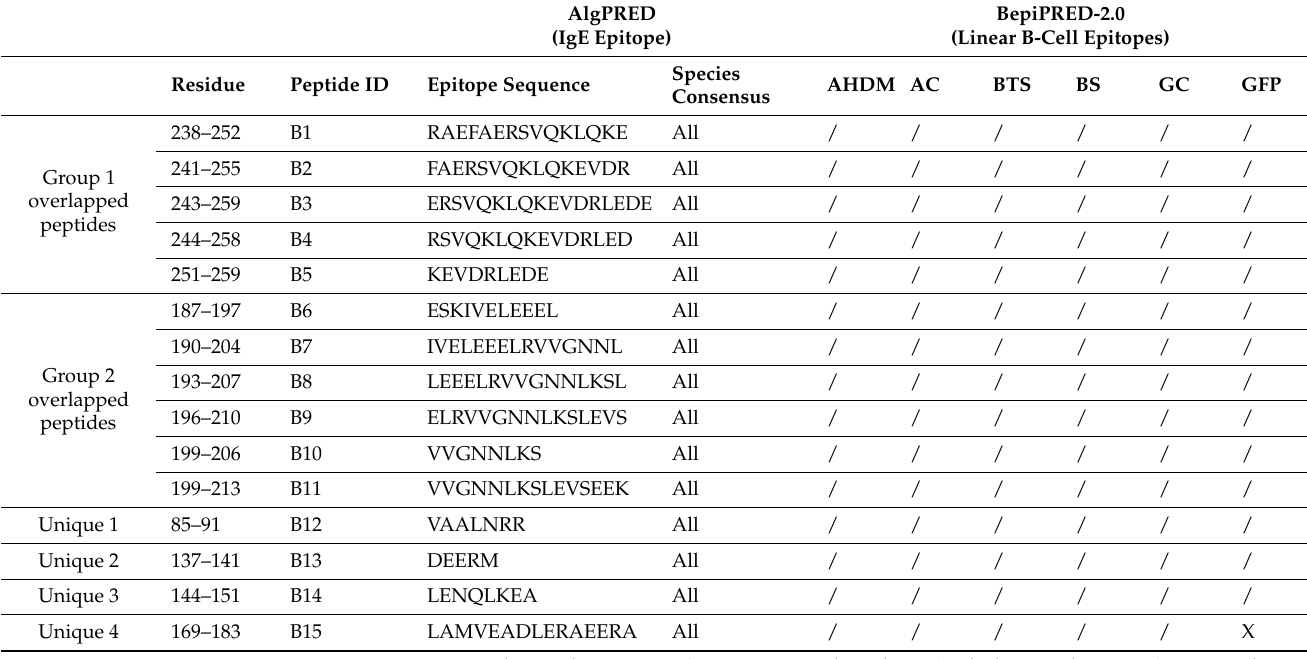
Table 2. Consensus linear B cell epitopes identified by AlgPRED and